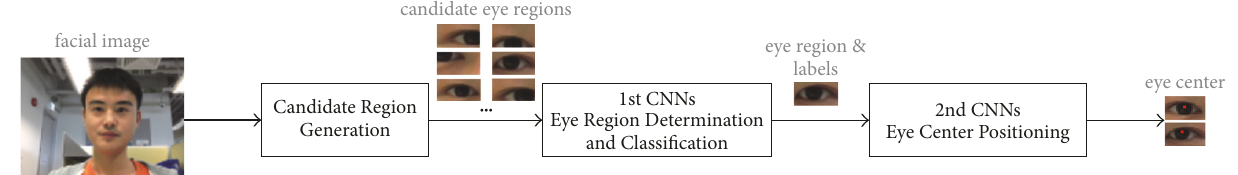
Figure 1: Workflow of the proposed method.